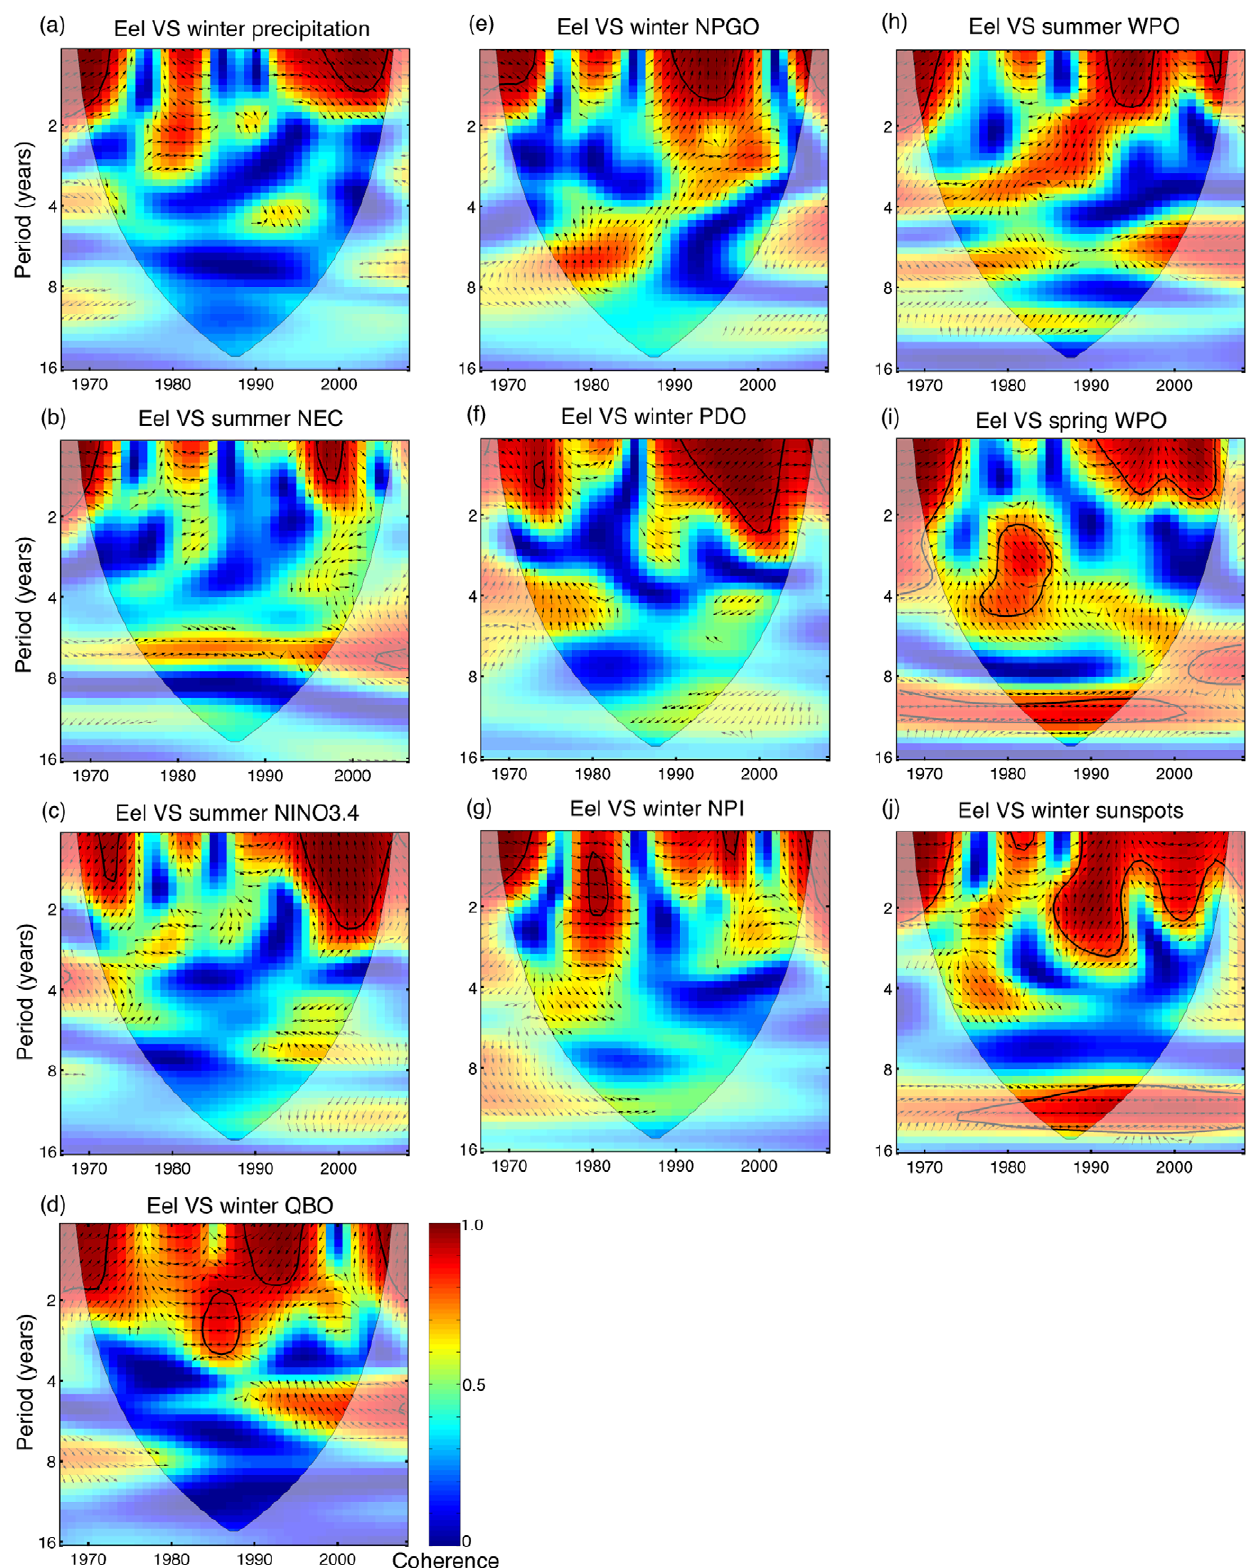
Figure 4. Cross wavelet coherence between log 10 (eel catch) and climate indexes: (a) winter precipitation at the eel spawning area, (b) summer NEC bifurcation, (c) summer Nin˜o3.4, (d) winter QBO, (e) winter NPGO, (f) winter PDO, (g) winter NPI, (h) summer WPO, (i) spring WPO, and (j) winter sunspot numbers. The solid black contour encloses regions of greater than 95% confidence, and the shadowed area indicates the cone of influence. The phase relationship is shown as arrows, with in-phase pointing right, anti-face pointing left, and the environmental variable leading the eel catches by 90 u pointing straight down. doi:10.1371/journal.pone.0030805.g004 PLoS ONE |